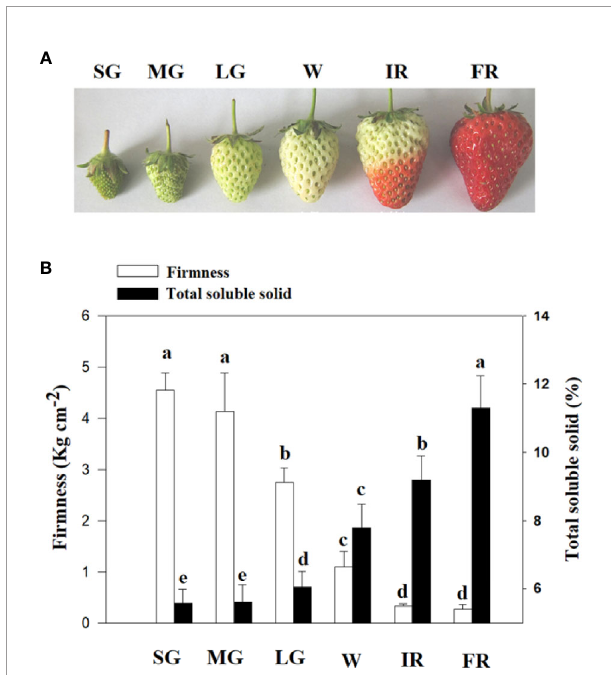
FIGURE 1 | Changes of total soluble solids (TSS) along with fruit development and ripening. (A) Phenotypes of fruits at different developmental stages, from fruit set to ripening. Six major developmental stages can be de fi ned: small green (SG), middle green (MG), large green (LG), white (W), and Initial reddening (IR) and Full reddening (FR). (B) Changes of TSS (Total Soluble Solid) along with fruit development and ripening. Changes in the fruit fi rmness indicates the progression of fruit development and ripening. Labels below the bars indicate the corresponding developmental stages as explained in (A) . Values are means ± SD of three biological replicates. Different letters denote signi fi cant differences at P <0.05 using a Student ’ s t